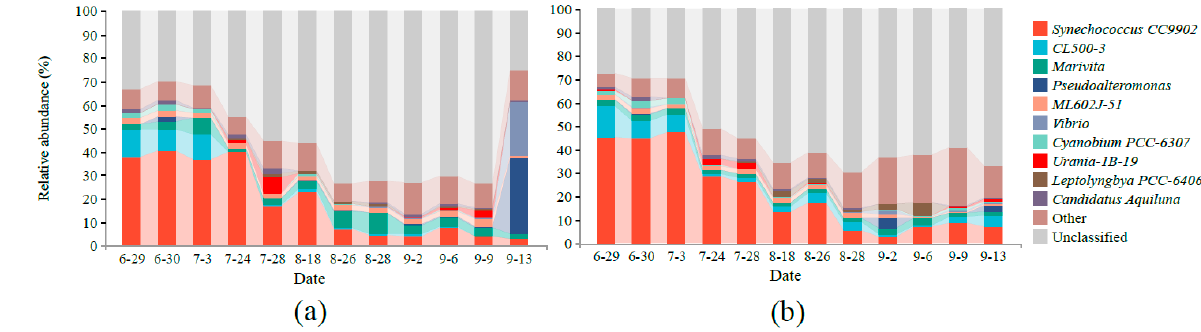
Figure 4. The relative abundance of the ten most abundant bacteria genera varied among treatments: ( a ) control pond, ( b ) MC-treated pond.